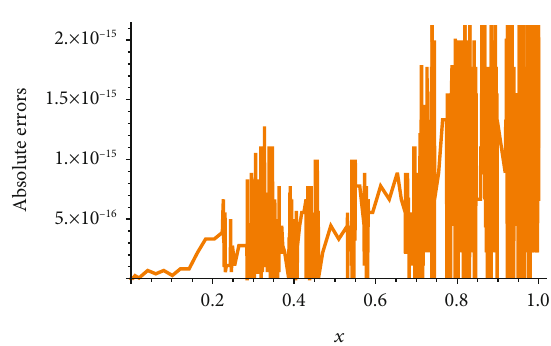
Figure 17: Absolute errors of u 1 obtained by the present method